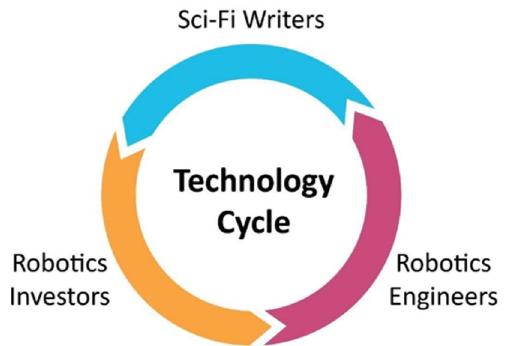
Fig. 7 Technology cycle